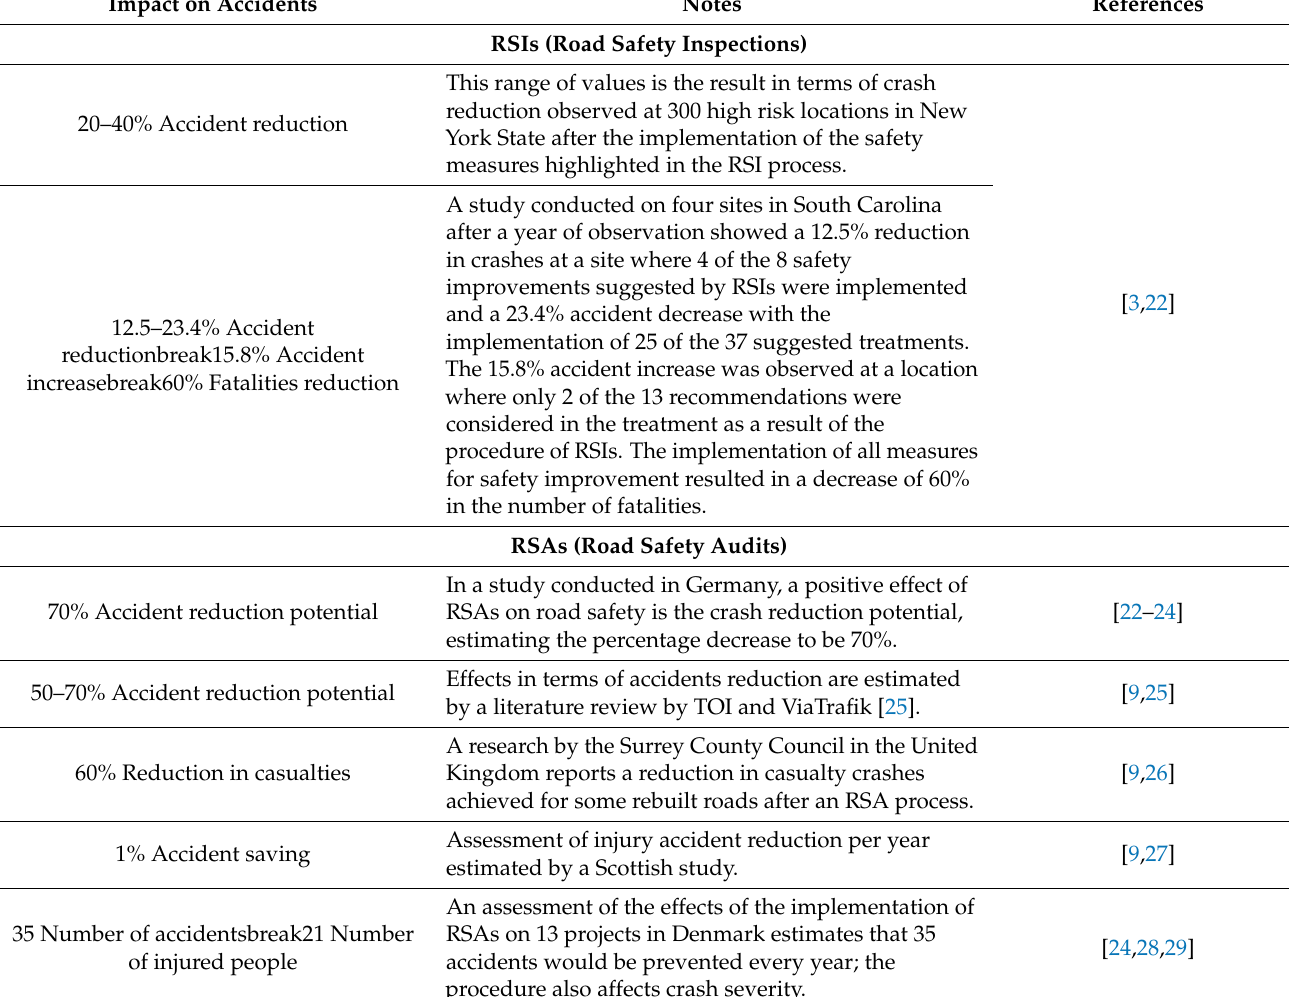
Table 1. Accident rate reduction in relation to road safety inspection (RSIs) and road safety audits (RSAs). Impact on